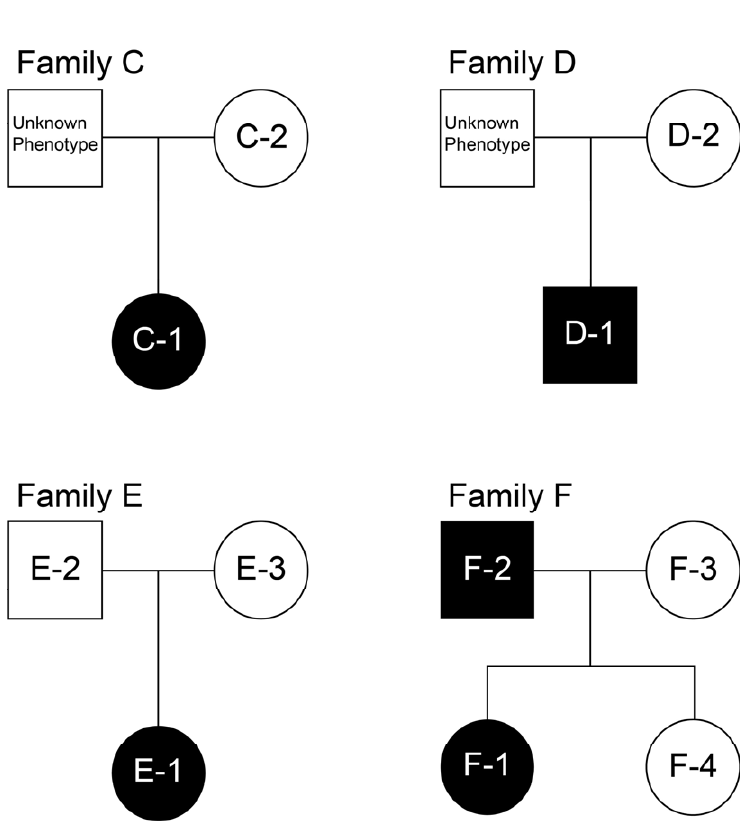
Figure 1. The family trees of families A–F. Square: male, circle: female, black background: fused teeth present, white background: fused teeth absent. Table 1. Clinical characteristics of the 15 patients from families A–F.